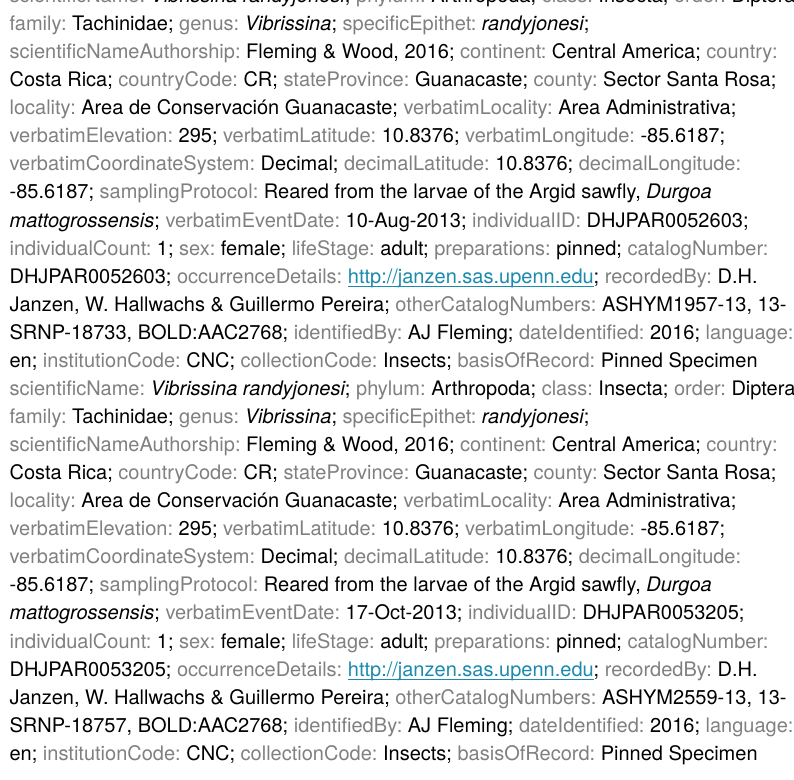
tomentose; parafacial, face, gena, postgena and postorbit golden gold tomentose; antenna black-brown; arista reddish brown basally, black apically; gena 0.24X eye height; 3 reclinate orbital bristles; lower frontal bristle not reaching beyond lower level of pedicel; fi rst fl agellomere short of facial margin by 1.5X length of pedicel. Thorax (Fig. 8a, c): dorsum gold tomentose with 4 distinct dorsal vittae visible pre and postsuturally; katepisternum all gold tinged with silver around margins; 3 strong katepisternal bristles; 2 pairs of discal scutellar bristles; apical scutellars weak and strongly divergent. Legs: black on all segments. Wings: smoky gray, bearing 1–3 short bristles dorsally at the base of R4+5. Abdomen (Fig. 8a): ground color of abdomen black on ST1+2, T3, and T4; T5 of light orange ground color at apex; mid-dorsal depression on ST1+2 extending almost to margin of syntergite; anterior margins of T3, T4, and T5 bearing silver tomentum over 1/2 of tergal surface, with a slight gold tinge directly adjacent to the tergal margin; T5 with silver tomentum over 4/5 or more; T3 and T4 bearing 3 pairs of median discal bristles; T5 bearing 2 rows of discal bristles; ST1+2 and T3 with 1 pair of median marginal bristles; T4 and T5 bearing 1 complete row of marginal bristles.